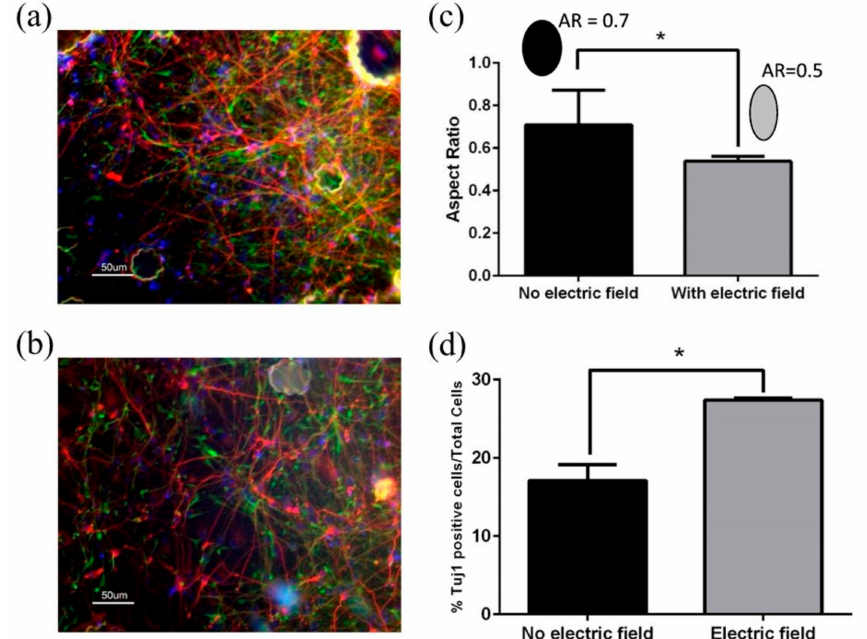
Figure 5. Immunofluorescence images of anti-Tuj1 (red) and anti-GFAP (green) followed by DAPI (blue) staining for the nuclei of the fetal NSCs on crosslinked PEDOT:PSS. NSCs di ff erentiation occurred on crosslinked PEDOT:PSS substrates without ( a ) and with ( b ) electric stimulation. ( c ) Quantification of aspect ratio of neurons. More than 30 cells were analyzed. ( d ) Quantification of percentage Tuj1 positive. * p < 0.05. Reprinted with permission [101] © 2020